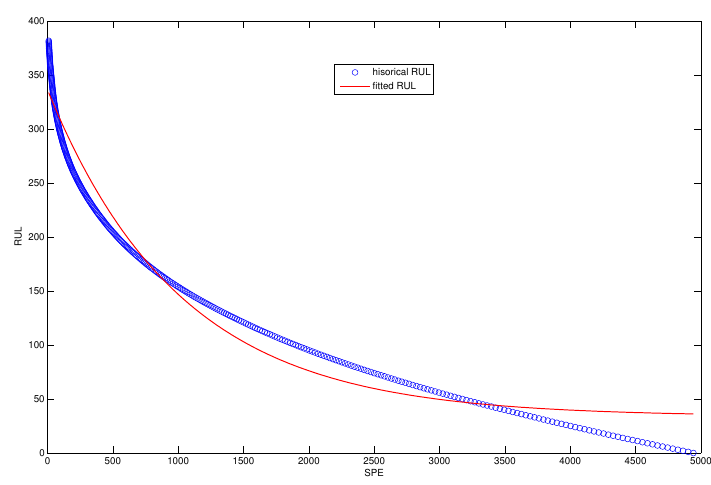
Figure 12. The fitted RUL prediction model based on the SPE damage precursor.